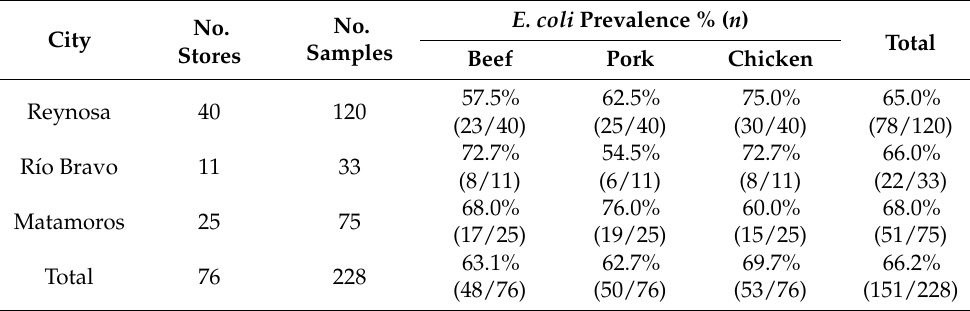
Table 1. Prevalence of E. coli strains in meat samples from northeast